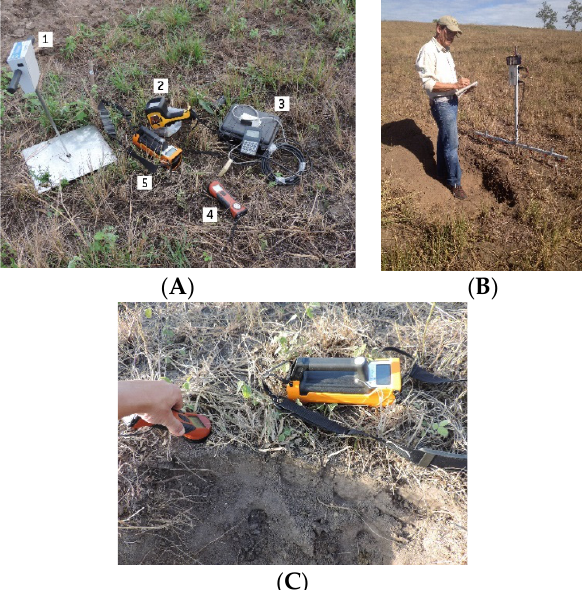
Figure 2. Proximal soil sensors used in the study ( A ), and the Rabellis ECa sensor ( B ) and KT-10 S/C MSa/ECa and RS-230 BGO gamma-ray sensors ( C ) taking in situ measurements. Source: Gustavo M. Vasques.